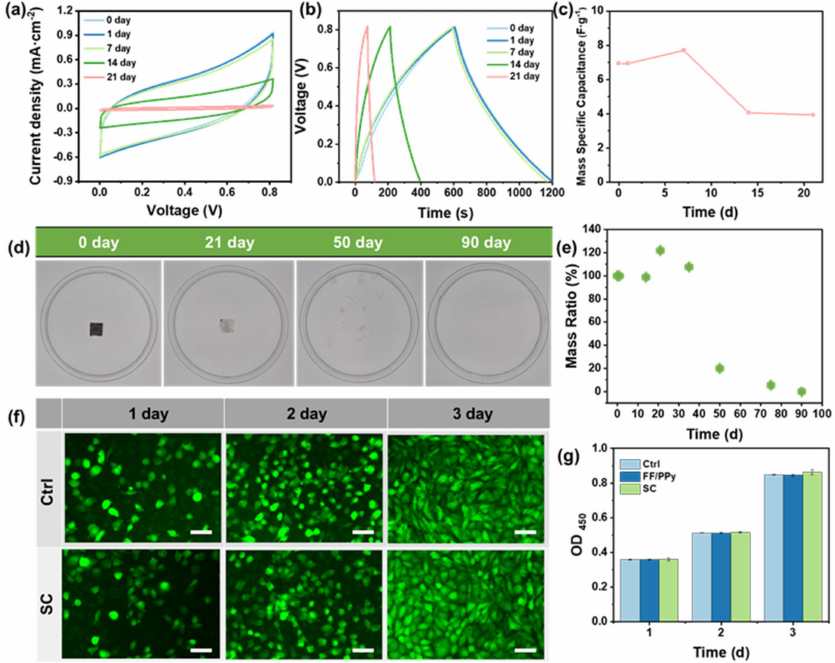
Figure 4. Capacitive performance and biodegradability of SCs in the liquid environment in vitro. Electrochemical performance test of SCs for a short-term in PBS at 37 ◦ C ( a – c ). The current density in ( b ) is 0. 2 mA · cm − 2 ; ( c ) the variation of mass specific capacitance during device’s degradation; ( d ) in vitro degradation of SCs in 1 × PBS buffer in a cell culture dish (inner diameter: 35 mm) at room temperature; ( e ) the mass variation of SCs during degradation; ( f ) biocompatibility of SCs. Attachment, proliferation, and morphology of the L929 cells at different times. Scale bars: 100 µ m; ( g ) the viabilities of L929 cells after being cultured for 3 days. All data are presented as the mean ±